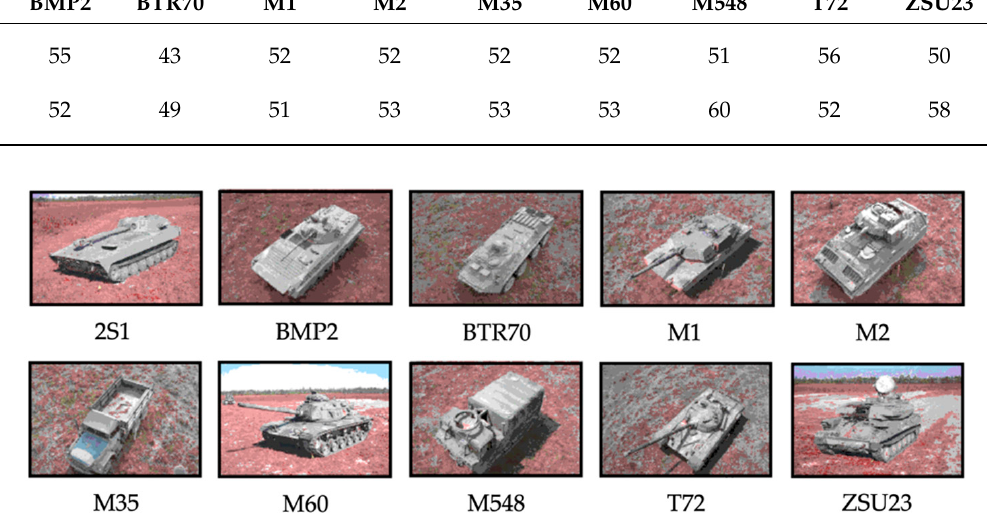
Figure 7. Examples of optical images of SAMPLE dataset targets.